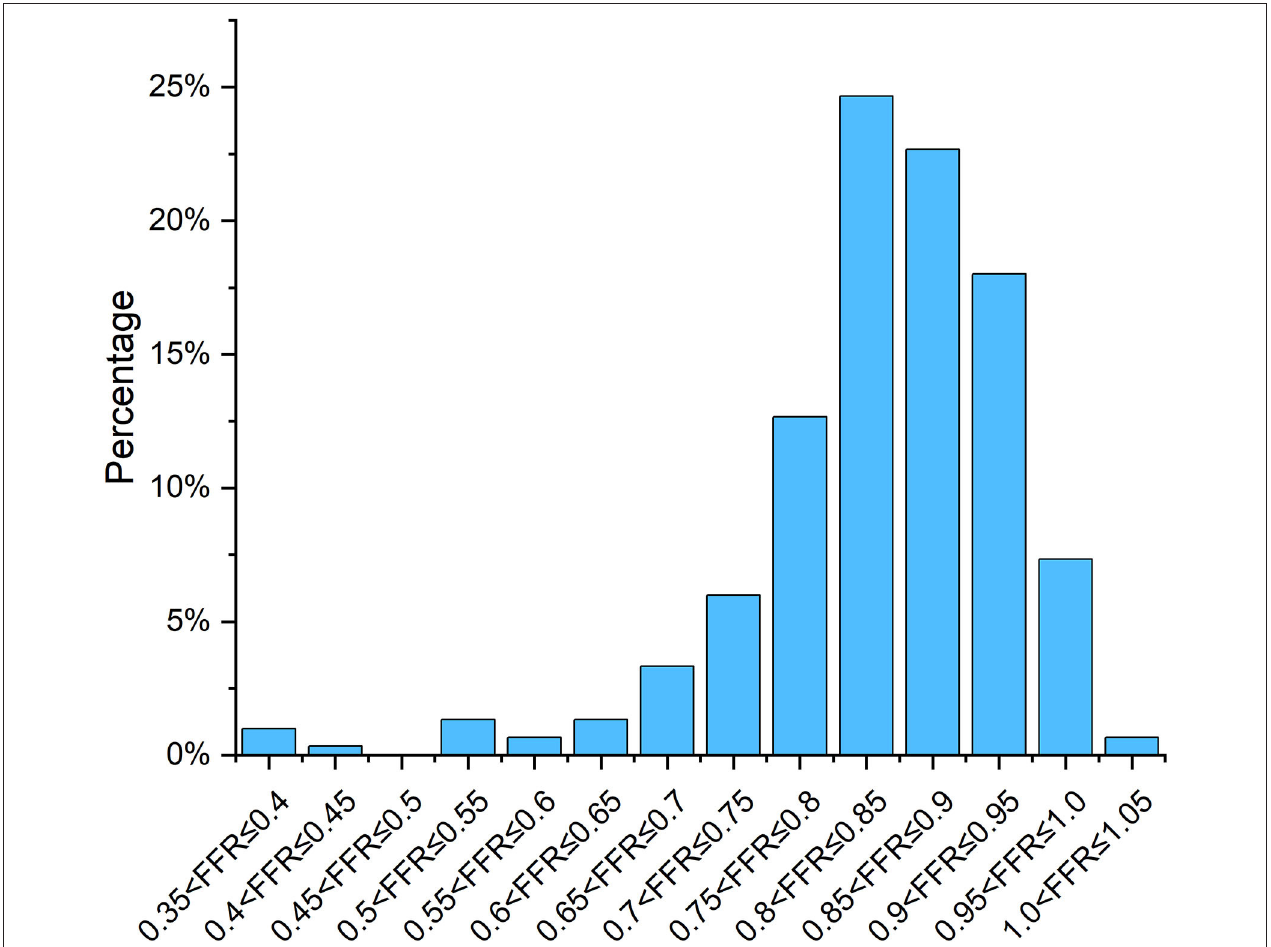
FIGURE 3 | Percent distribution of invasive